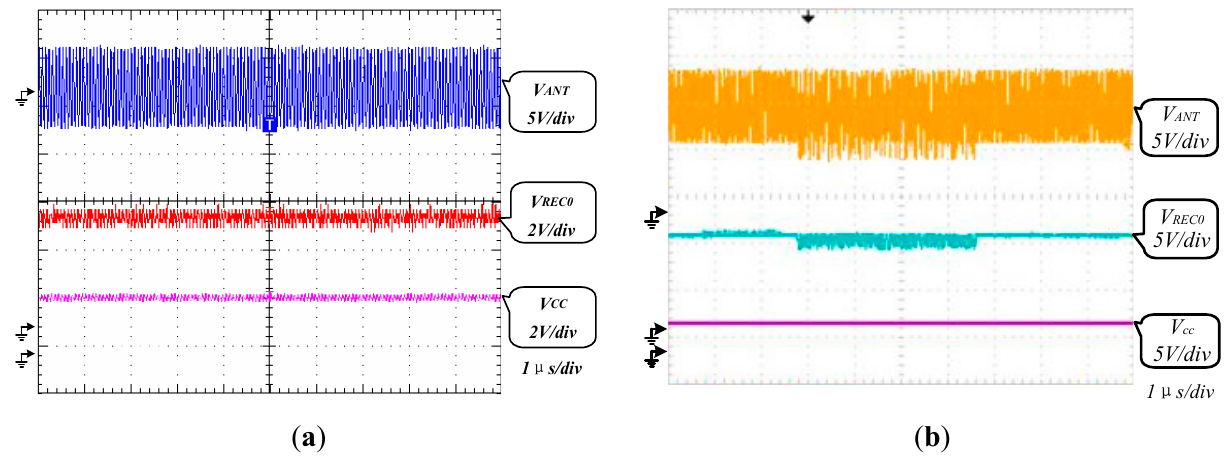
Figure 9. ( a ) V test waveform when H = 0.3 A/m under 0.25 µm process, V CC (rms); ( b ) V test waveform when H = 4 A/m under 0.25 µm process, V cc